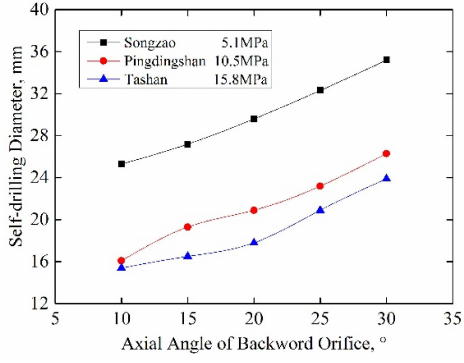
Figure 14. Graph showing the relationship between borehole diameter and backward orifice axial angle. Strength of coal samples: 5.1, 10.5 and 15.8